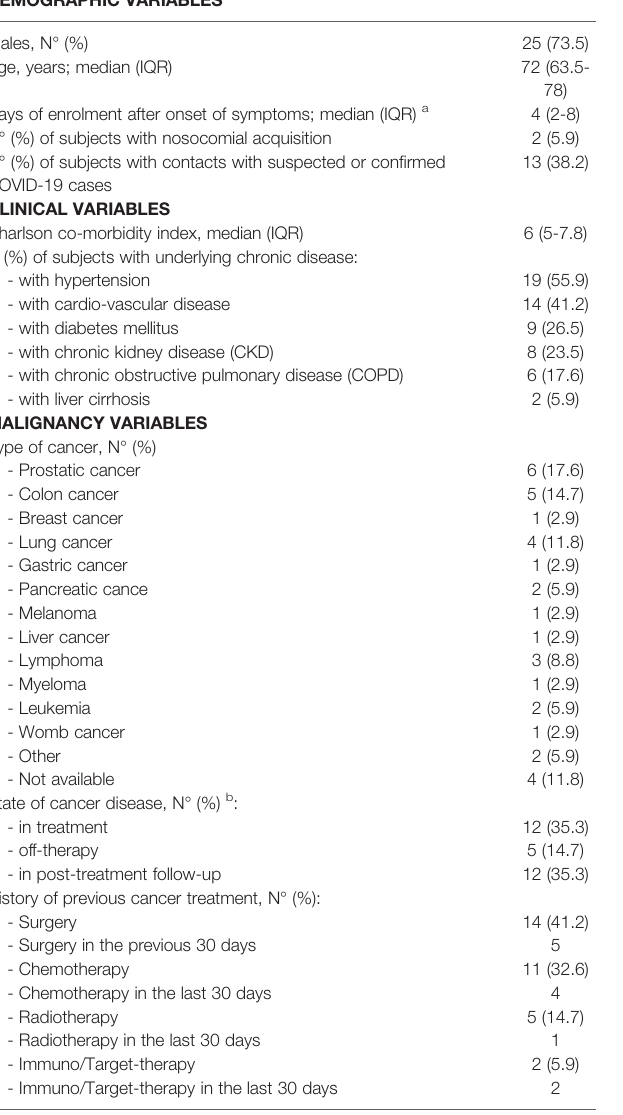
TABLE 1 | The demographic and clinical characteristics of the 34 patients with cancer. DEMOGRAPHIC VARIABLES